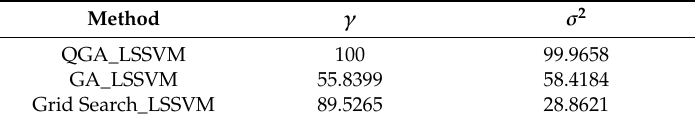
Table 7. The optimized parameters for the vibration signal.